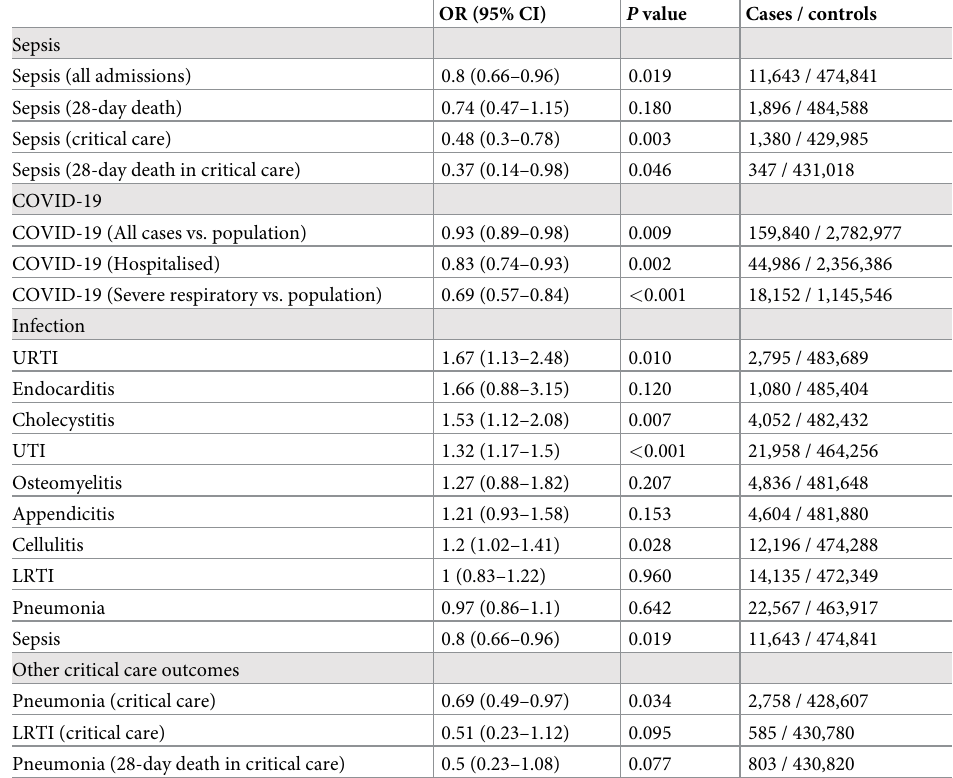
Table 1. IVW meta-analysis of MR estimates of IL6R blockade for UK Biobank and COVID-19 HGI